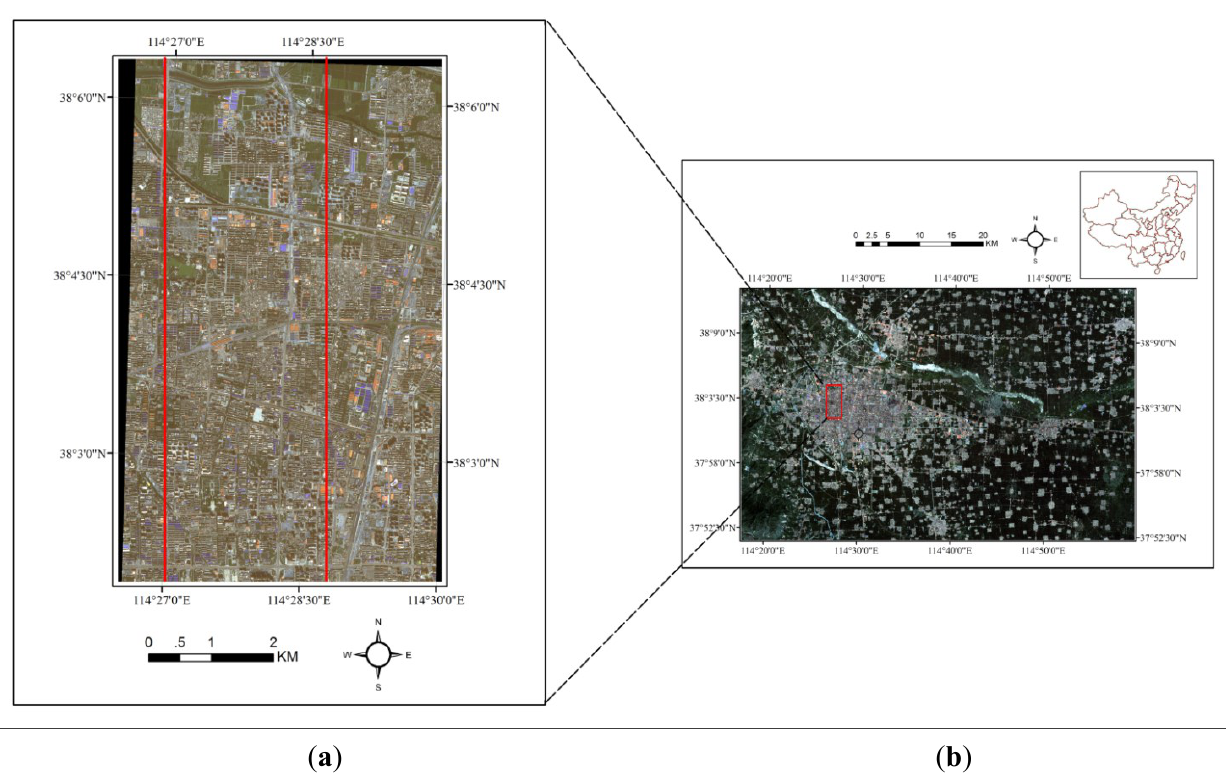
Figure 1. Study area in Shijiazhuang, China. ( a ) WordView-2 RGB color composite of the study area. Line 1 (Left) and 2 (Right) are two north–south direction profile transects. ( b ) Location of the study area and Landsat TM